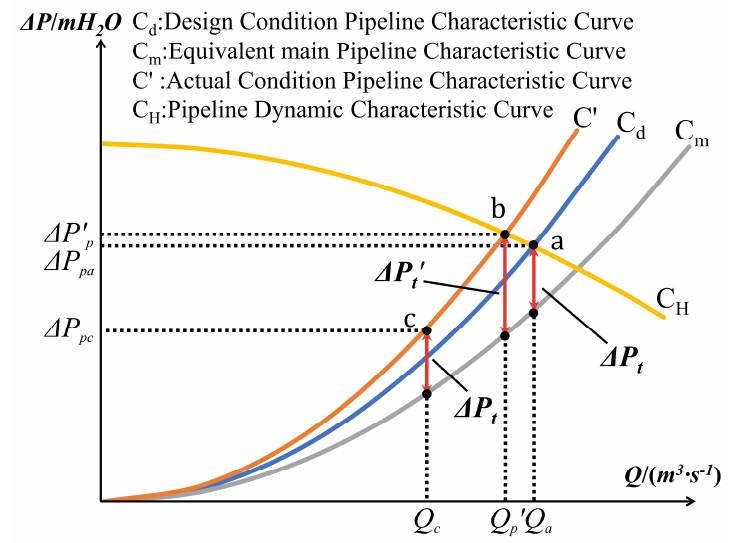
Figure 3. Measurement control system diagram. a represents the operating state point of the pipeline under design working conditions; b represents the operating state point of the pipeline with the user adjusting the terminal; and c represents the operating state point of the pipeline utilizing this strategy.